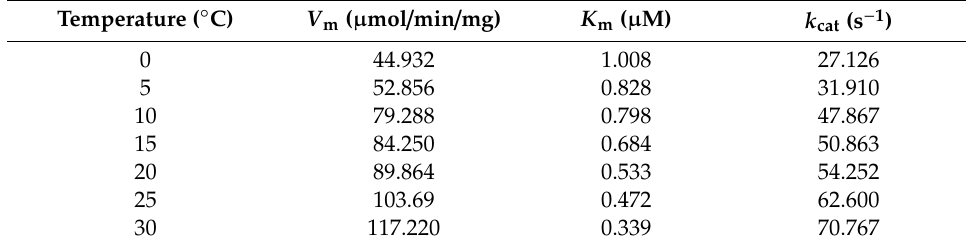
Table 3. The kinetics parameters of the rPsRNR.